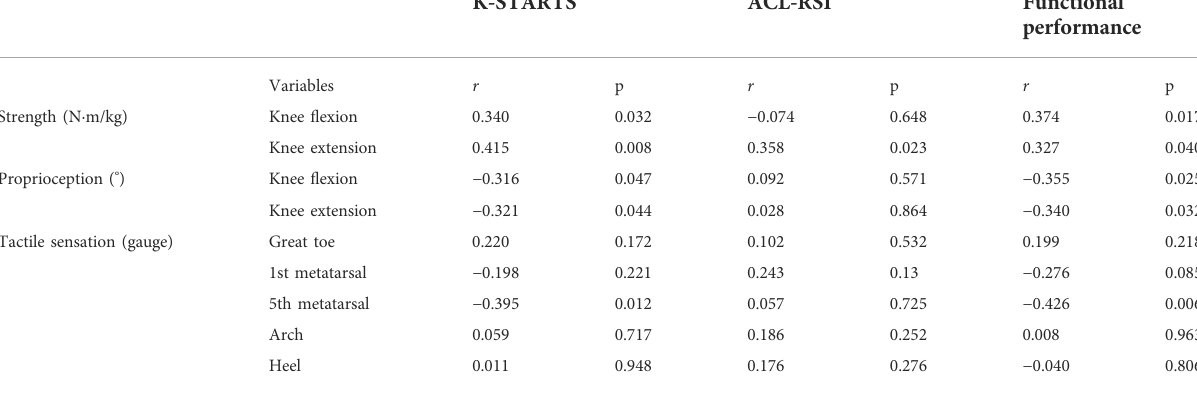
TABLE 2 Partial correlation outcomes of K-STARTS, ACL-RSI, and functional performance with strength, proprioception, and tactile sensation